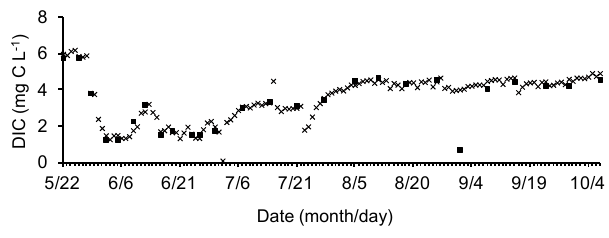
Fig. 5. Comparison of daily DIC concentrations in stream 5 (crosses) and grab samples (filled squares) from the same stream. Table 4. Flow-weighted annual DOC and DIC concentrations and mass fluxes for the six catchments considered in this study. Uncer- tainties are based on an assumed ± 15% measurement error asso- ciated with the rating curve and the uncertainty from the